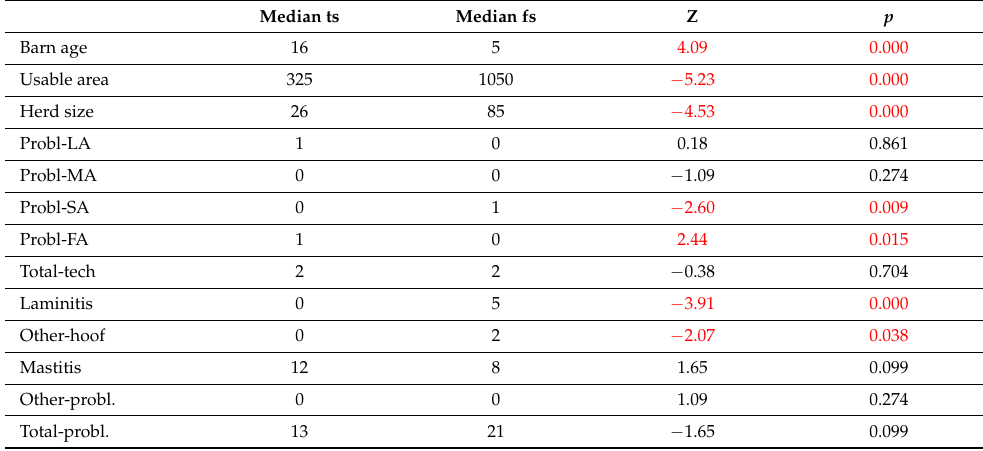
Table 7. Results of the Mann–Whitney U test for the variable: Housing system; marked results (in red) are significant with p <